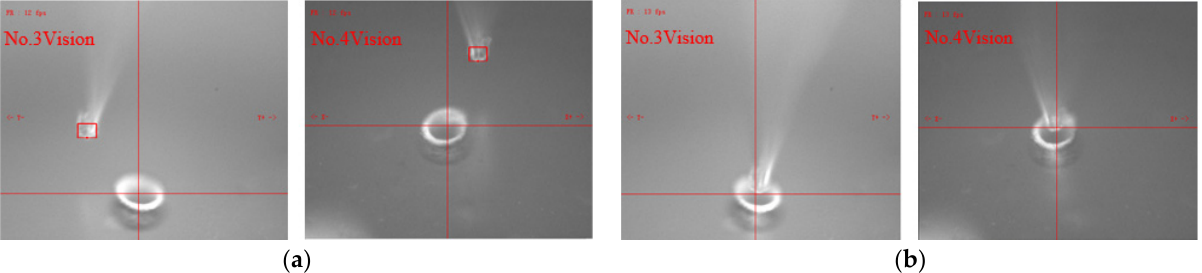
Figure 11. Image of position fine alignment: ( a ) images before alignment; ( b ) images after align- ment.